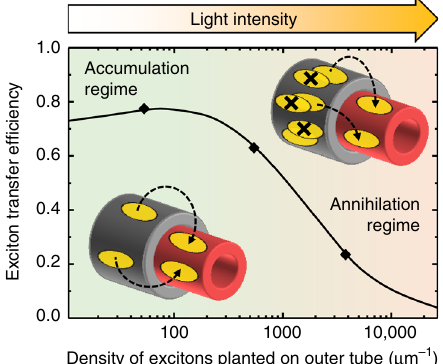
Fig. 6 Exciton transfer regimes. Exciton transfer ef fi ciency, i.e., fraction of excitons that were planted on the outer tube and either decayed naturally or annihilated on the inner tube as a function of linear exciton density (i.e., the number of excitons per unit of nanotube length), obtained from MC simulations (black line). Symbols indicate exciton densities used in the experiments. In the simulations also the inner tube is populated with excitons at time zero with the same exciton density as the outer tube. The insets schematically depict the exciton (orange ellipses) dynamics in the accumulation regime (bottom left) and the annihilation regime (top right). Dashed arrows: exciton transfer; black crosses: exciton – exciton